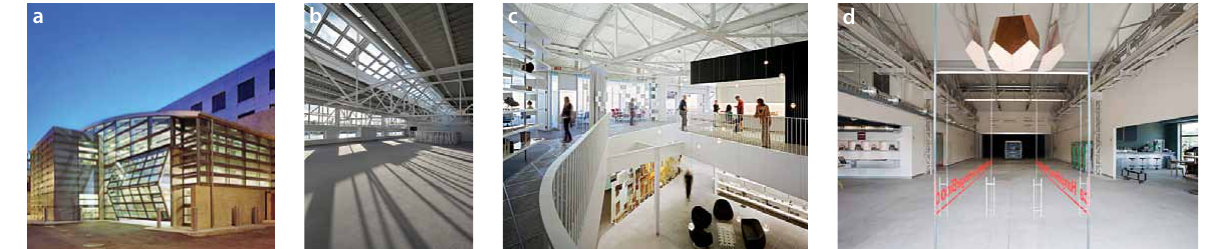
fig. 1. The examples of hangar reconstruction: a – in Cambridge, uSa (photo by Cambridge Seven associates); b – in rouen, france (photo by Bigoni S.); c – in California, uSa (photo by oudeman f.); d – in Milan, Italy (photo by osio